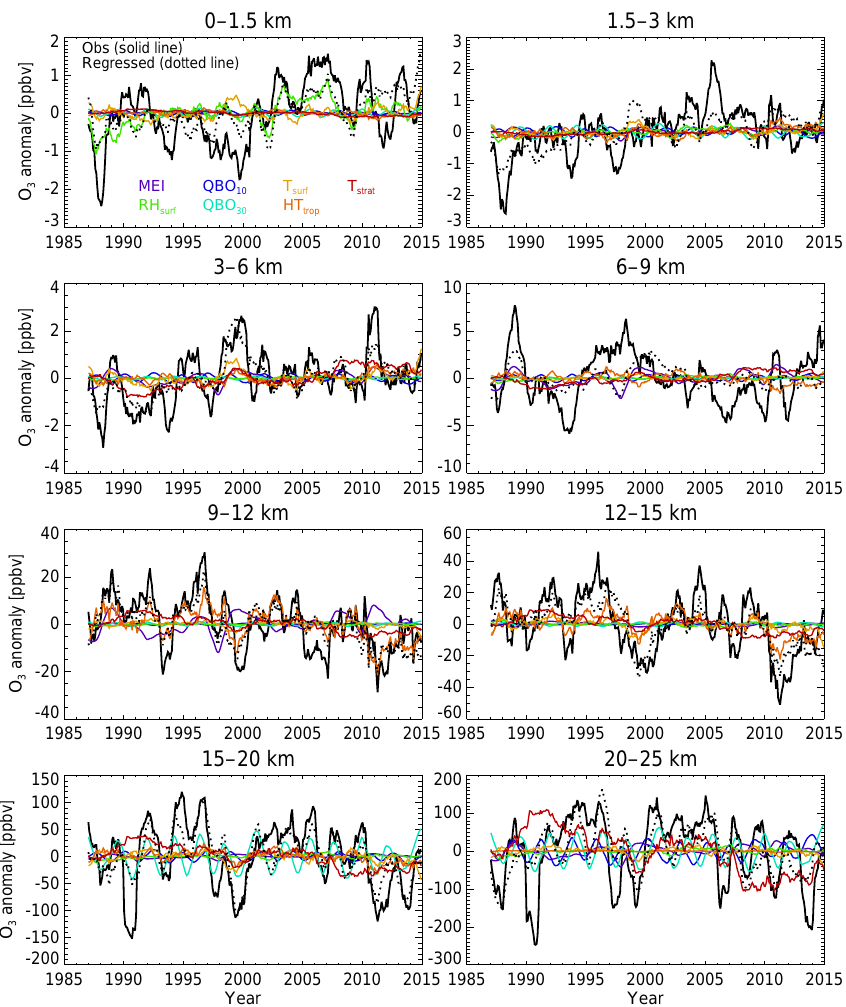
Figure 3. Ozone anomalies and contributions of individual regression functions at Lauder. O 3 anomalies are monthly mean but are smoothed using a 13-month filter for display. Colour keys for regressors are shown in the top-left